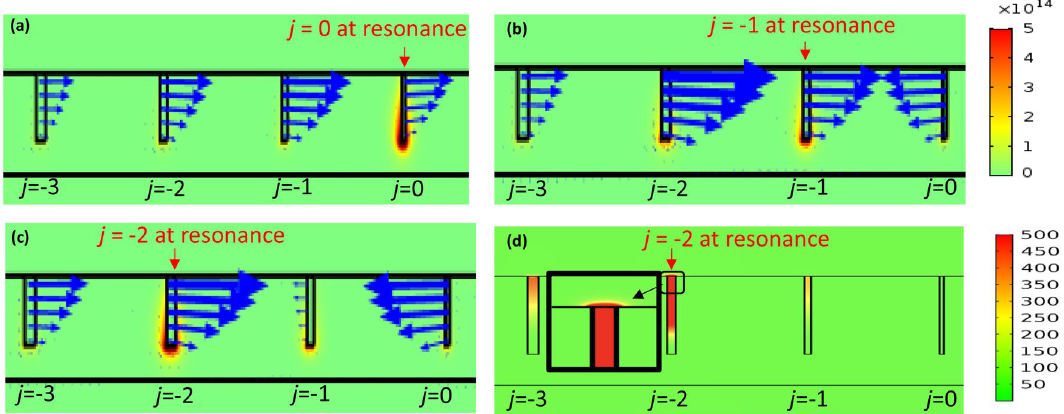
Figure 6. ( a ) j = 0, ( b ) j = − 1, and ( c ) j = − 2 correspond to λ resonant = 5.264 µm, 4.478 µm, and 4.167 µm, respectively, where the groove under resonance is labelled/identified. Total power dissipation density, the rainbow colors surrounding each groove, shows the amount of dissipated electric field which is evidently highest at the bottom of the groove under resonance. The blue vectors show the direction of the scattered electric field, real part of −→ E x , within each groove. These vectors in any groove point towards the groove under resonance and thus demonstrate how adiabatic mode transformation dictates that all non-resonating grooves direct their scattered field −→ E x towards the resonating groove. ( d ) Normalized field intensity map of the graded grating when groove j = − 2 is under resonance at 4.167 µm. Note that the maximum field is localized within this groove in comparison with the rest. The inset in this figure shows the localized field and in particular the field extending a few nanometers (~ 10 nm) above the nano-groove surface . The scale bar on the right of Fig. 6b corresponds to ( a – c ) while the scale bar to the right of Fig. 6d corresponds to ( d ). Figures were obtained using COMSOL Multiphysics, version 5.3. COMSOL Inc, http://www.comso toward the resonating groove. Our simulation results show that this adiabatic mode transformation occurs for every groove only when 300 nm ≤ d ≤ 900 nm. This in turn leads to enhanced multiwavelength localization of light. Under these conditions of adiabaticity, the graded grating structure is said to be impedance matched such that the energy is efficiently transferred from the incident light to the SPPs on the surface of the grating and to the photonic modes of the grooves. For 50 nm ≤ d < 300 nm, Re( −→ E x ) in the grating changes its direction multiple times above the resonant frequency and thus does not allow coupling of a single dominant plasmonic resonant mode to the grooves, thereby leading to poor multiwavelength localization. Please refer to supplementary infor- mation where Figs. S1a and S2a show profiles of the Re( −→ E x ) across visible and near-IR regions for d = 300 nm and d = 100 nm, respectively, and Figs. S1b and S2b show corresponding variation of phase of E x . Also, see sup- plementary information Visualization 1 animating the behavior of Re ( −→ E x ) and the resonance profile of the graded grating for d = 100 nm and d = 300 nm, at L = 100 nm. Figure 6d shows a plot of the normalized field intensity localized within the nano-grooves when j = − 2 is under resonance. This figure represents the field map of the structure in Fig. 5b at the resonant wavelength of groove j = − 2 which is λ resonant = 4.167 µm. The field localized within the groove is situated towards the top of cavity and extends about 10 nm above the resonating nano-groove surface. Please see the supplementary information Fig. S6 for a resonant field map within a lamellar uniform-width grating structure corresponding to the resonant profile shown in Fig. 5a. The reason for non-adiabatic behaviour of −→ E x for d < 300 nm is that the propagation constant of the SPPs on the grating surface is smaller than those resonating within the groove, thus preventing their coupling. However, under adiabatic mode transformation, for 300 nm ≤ d ≤ 900 nm, the propagation con- stant of the SPPs on the grating surface is larger or equal to those resonating within the groove which allows for mode coupling in between the grooves, based on Eqs. (6) and (8). Table 2 shows the resonance profile of a (non-symmetric) one-sided graded grating. The resonant wavelengths and intensities of this structure are similar to that of a symmetrically graded grating, except for the localized field intensity in the center groove ( j = 0) of the symmetric grating which is twice as large as that in the non-symmetric grating. This result demonstrates that the graded grating not only exhibits multiwavelength light localization, but also serves as a waveguide to propagate the off-resonant modes from the outer-lying wider grooves toward the narrower central-lying grooves. At a groove depth of L = 100 nm, only the first plasmonic mode is excited within the nano-grooves. However, deeper nano-grooves excite additional plasmonic modes and Table 2 shows that the nano-grooves support up to 5 plasmonic modes at L = 500 nm. Evidently, the smallest groove ( j = 0) supports additional localized modes compared to the neighboring wider nano-grooves. These numerical observations also corroborate with our theoretical calculations in Fig. 2 wherein the relationships between the wavelength of the localized field, groove depth, width and mode number are shown. FWHM and Q factor of the graded gratings for different values of d is tabulated in Table 2. An optimized graded grating structure should possess a small FWHM, large Q factor, and multiwavelength localization in all grooves. Based on Table 2, the FWHM and Q factor of a shallow graded grating with L = 100 nm ranges between 146 and 185 nm and 5.28–8.57, respectively. Whereas a deeper graded grating with L = 500 nm offers better values of FWHM and Q factor for higher order modes, albeit at the cost of reduced intensity for these localized